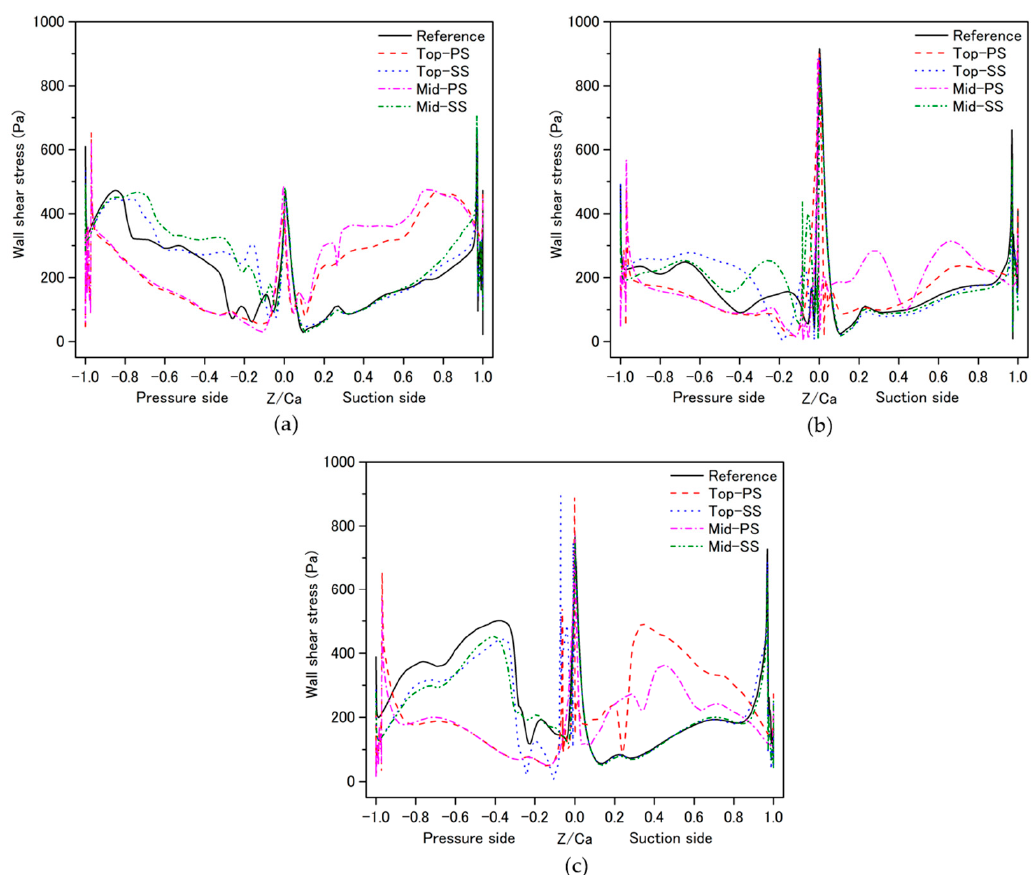
Figure 9. Wall-shear stress plots at different spanwise locations of rotor blades under different damaged-blade conditions: ( a ) near-hub (hub +5%); ( b ) midspan; ( c ) near-shroud (shroud − 5%).